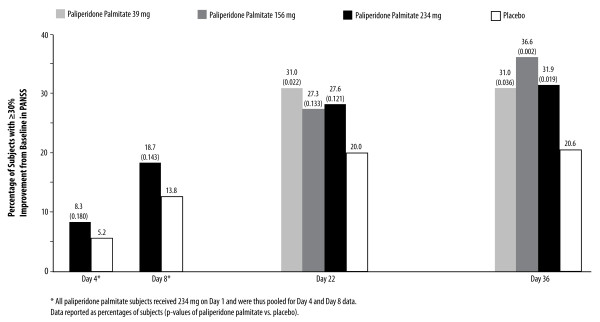
Responders: ≥30% Improvement from Baseline in PANSS Total Scores. The responder rates were significantly higher with paliperidone palmitate (all dose groups) than with placebo by the Day 36 timepoint.